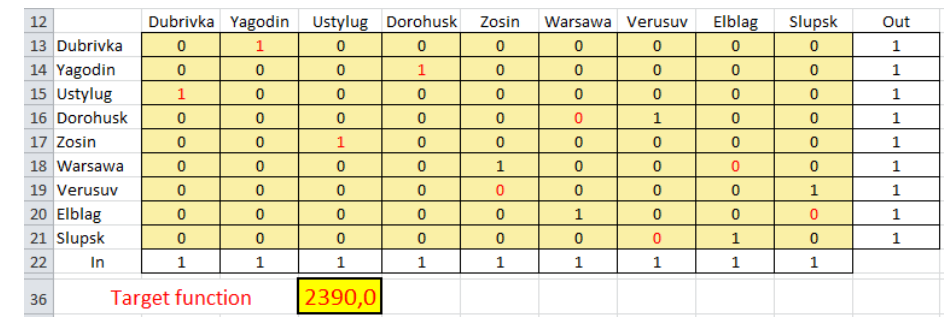
Figure 7. Obtaining the final